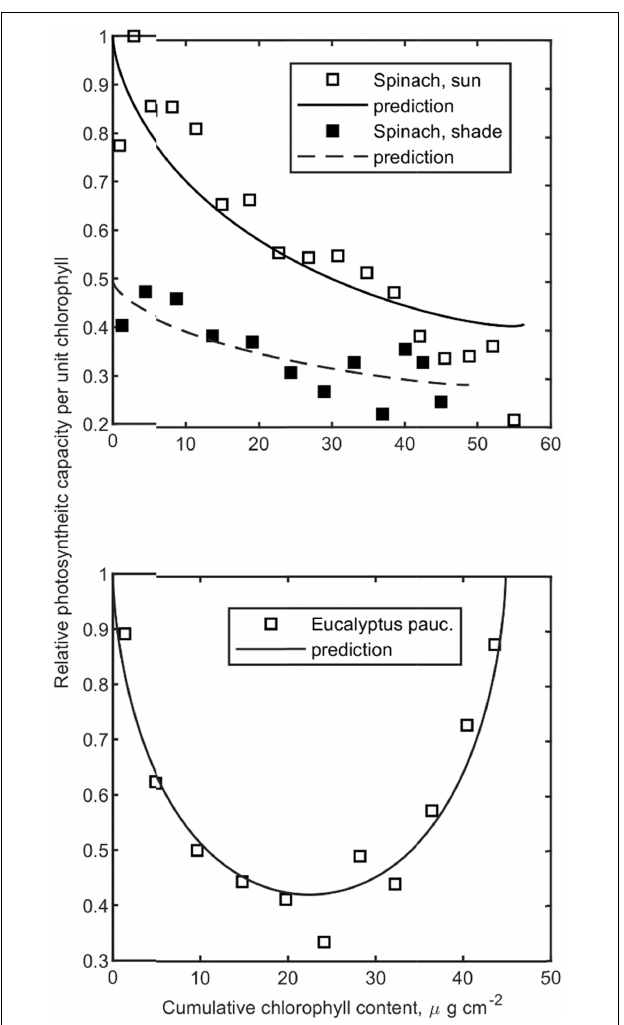
FIGURE 4 | Relative photosynthetic capacity vs. cumulative Chl . (Upper graph) Sun [ k = 0.1457, fitted p 3 = 0.53 (0.458–0.628)] and shade [ k = 0.1455, fitted p 3 = 0.36 (0.156–0.559)]-treated horizontal spinach leaves (w u , g = 0.9, Nishio et al., 1993). (Lower graph) Vertical isobilateral leaves of E. pauciflora ( k = 0.2535, fitted p 3 = 0.73 (0.675–0.789), w u , g = 0.5, Evans and Vogelmann, 2006). Confidence limits are given in parenthesis, p = 0.05.